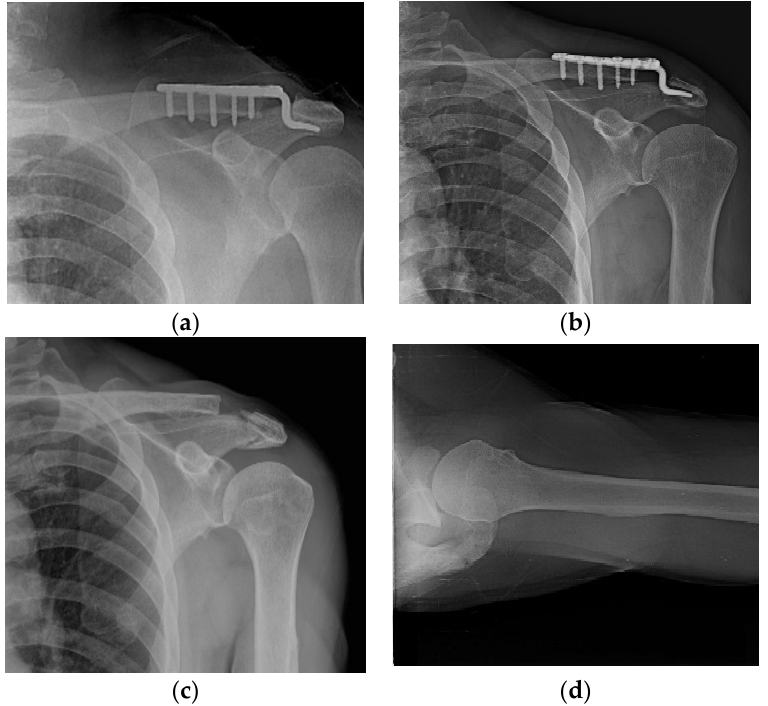
Figure 3. Acromial fracture. ( a , b ) Acromial fracture may be developed by frictional movement between the hook and the acromion; ( c , d ) fracture healing is shown without any additional procedure.